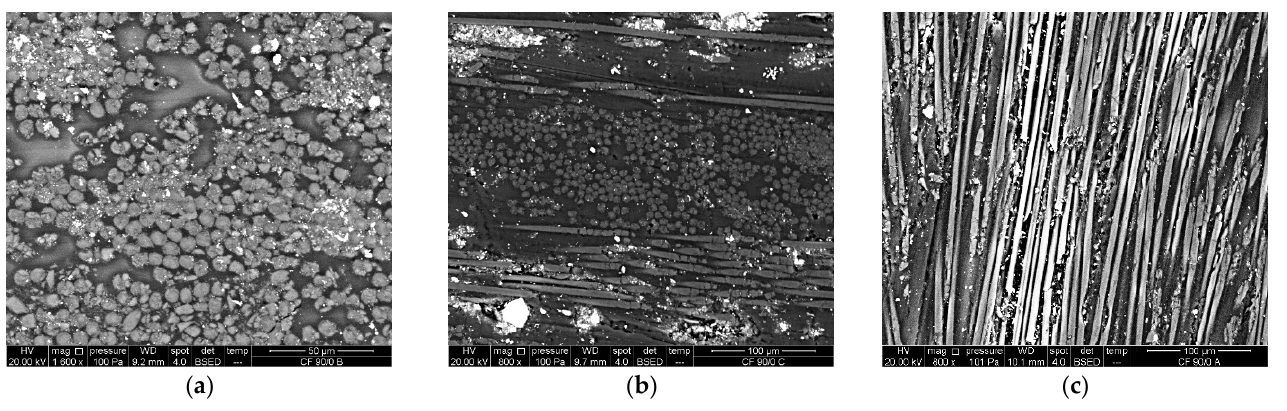
Figure 4. CFRP SEM images: ( a ) y-z cross-section 1600× magnification, ( b ) x-z cross-section 800× magnification, and ( c ) x-y cross-section 800× magnification.